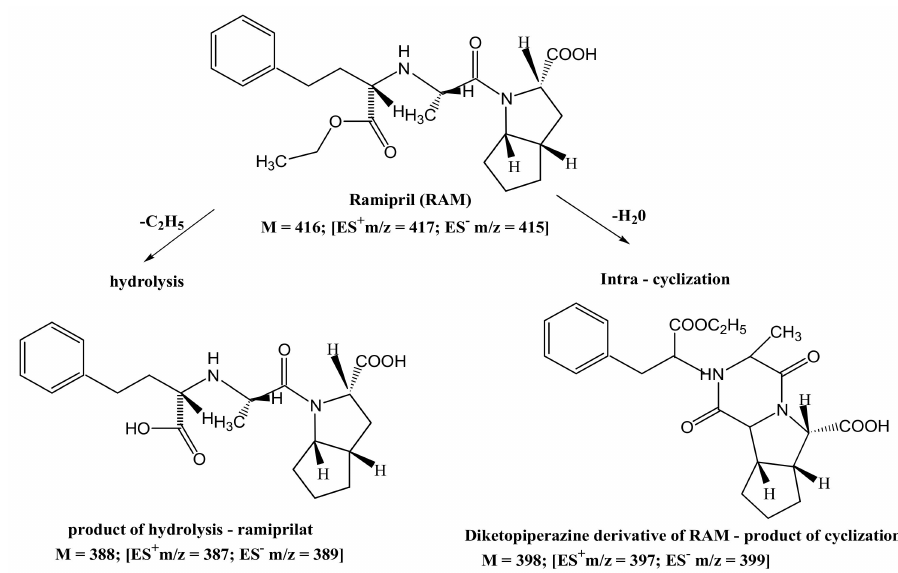
Figure 7. Proposed degradation pathway of RAM in the solid